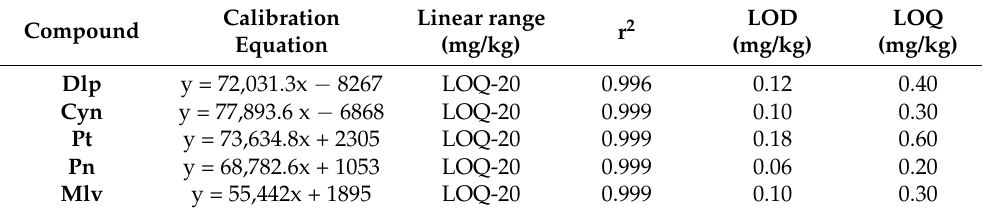
Table 3. HPLC-DAD validation parameters.